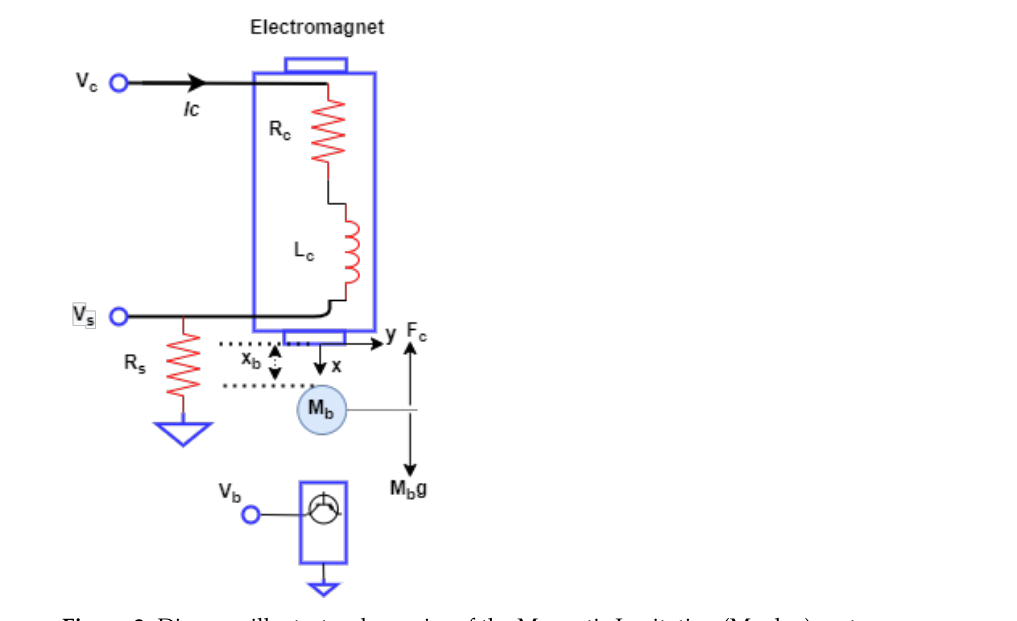
Figure 2. Diagram illustrates dynamics of the Magnetic Levitation (Maglev) system. Table 1. Nominal values of simulation parameters.